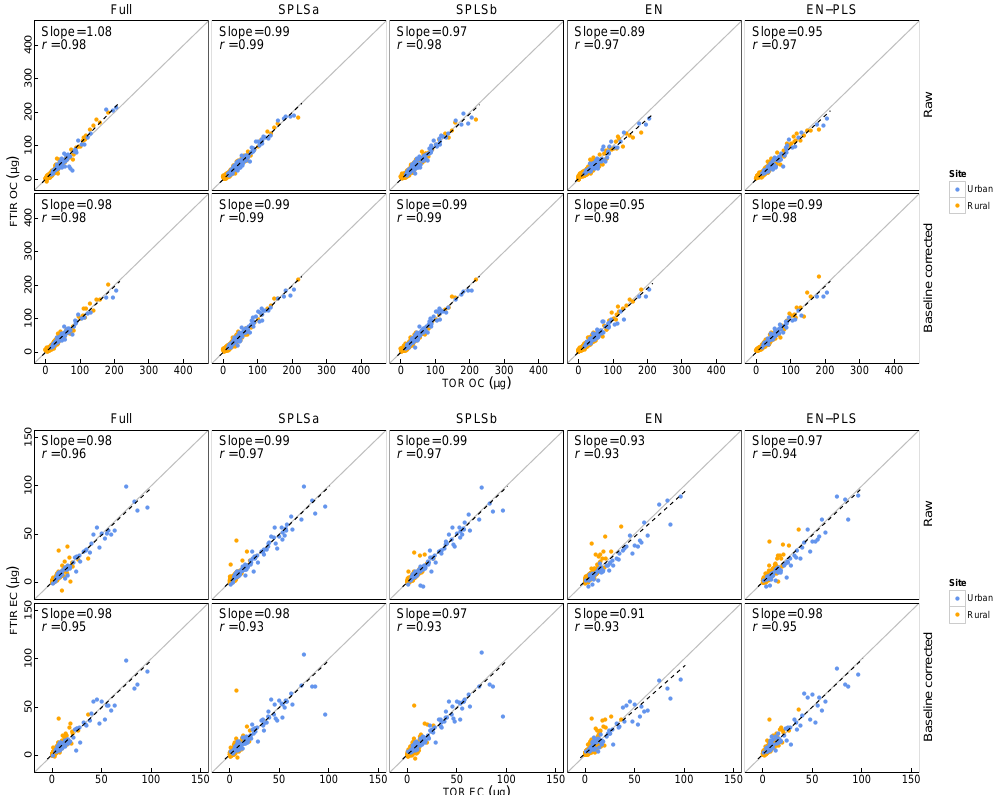
Figure 5. Predictions vs. reference for ambient samples (direct